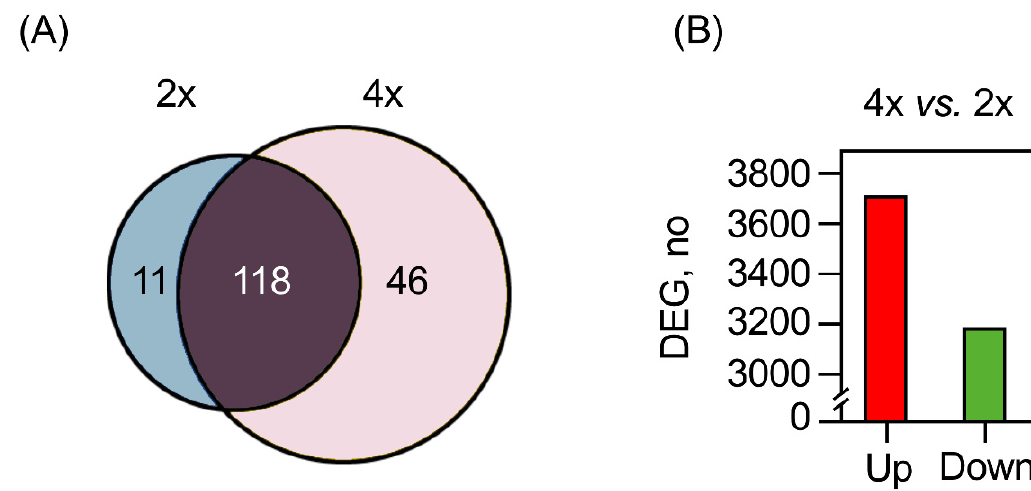
Figure 2. ( A ) Venn diagram showing the number of common and unique pre-miRNAs identified in 2x and 4x S. commersonii . ( B ) Number of differentially expressed genes (DEGs) obtained comparing 4x S. commersonii with its 2x progenitor.